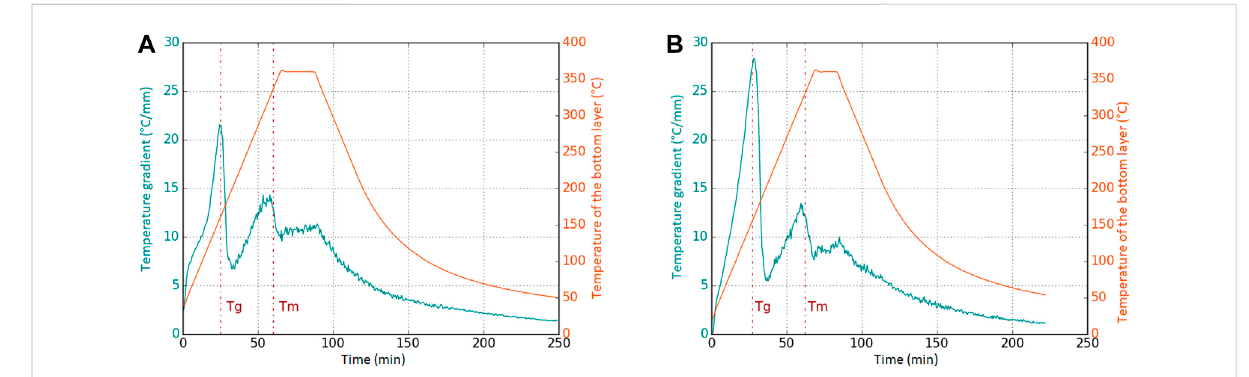
FIGURE 6 Temperature gradient evolution during the consolidation cycle (A) Prepreg A (B) Prepreg B.